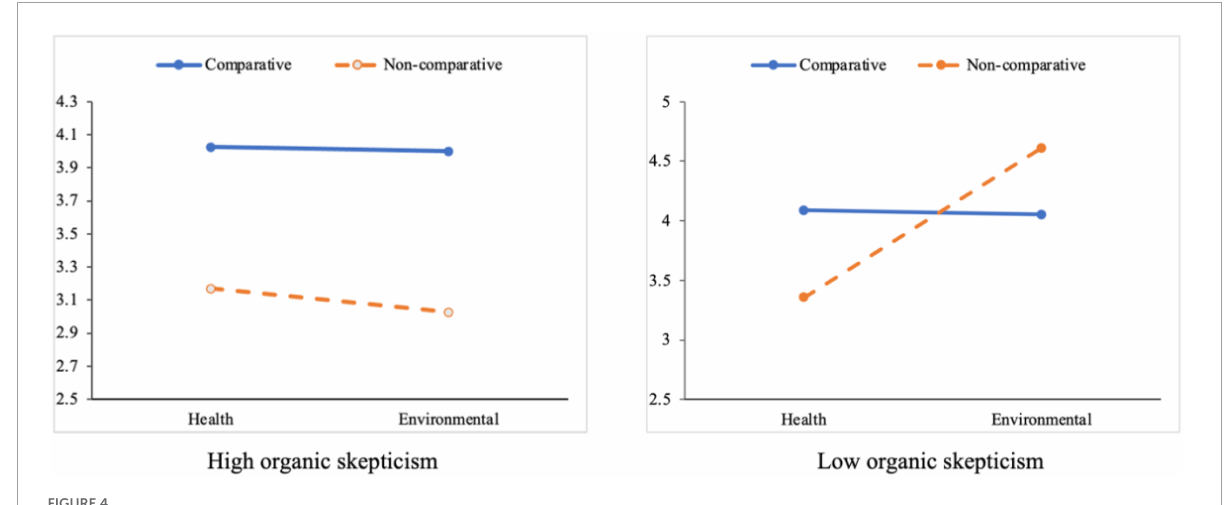
FIGURE4 Information persuasiveness by CA claims, benefit appeal, and organic skepticism